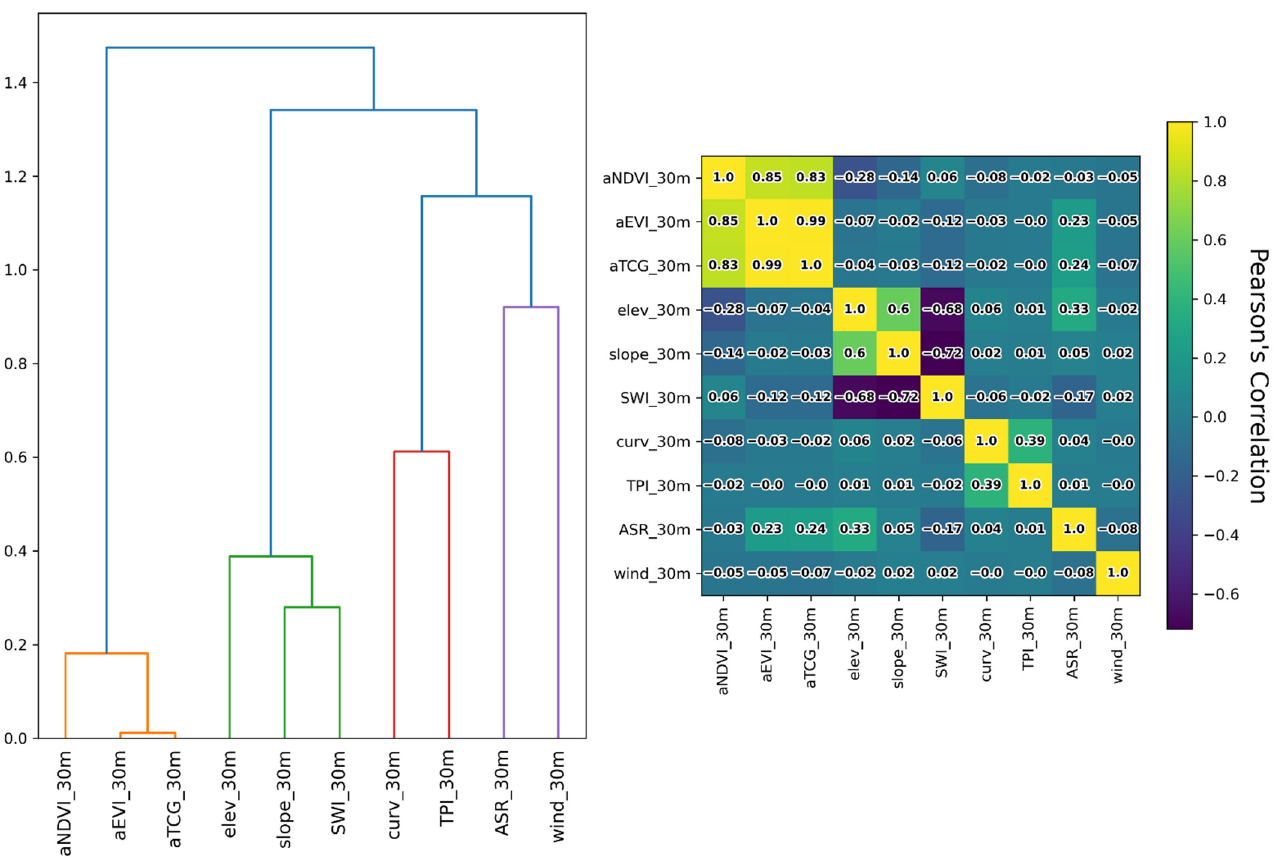
Figure 5. Hierarchical clustering dendrogram based on Ward’s method ( left ) [79] and Pearson’s correlation matrix ( right ) of the ten predictor features at the highest resolution considered in this study. Four main clusters are identified: vegetation features: NDVI, EVI, and TCG; major topography features: elevation, slope, and SWI; minor topography features: curvature and TPI, and meteorological features: ASR and the wind factor.